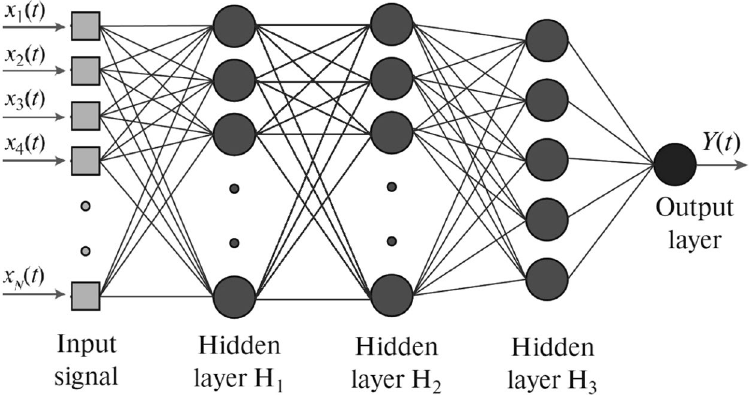
Figure 2. Multilayer perceptron (MLP) with input layer (IL) supplied by N inputs from informative MEG channels ( x 1 , … , N ), three hidden layers (H1, H2 and H3) with 30, 15 and 5 neurons, respectively, and output layer (OL) with a single